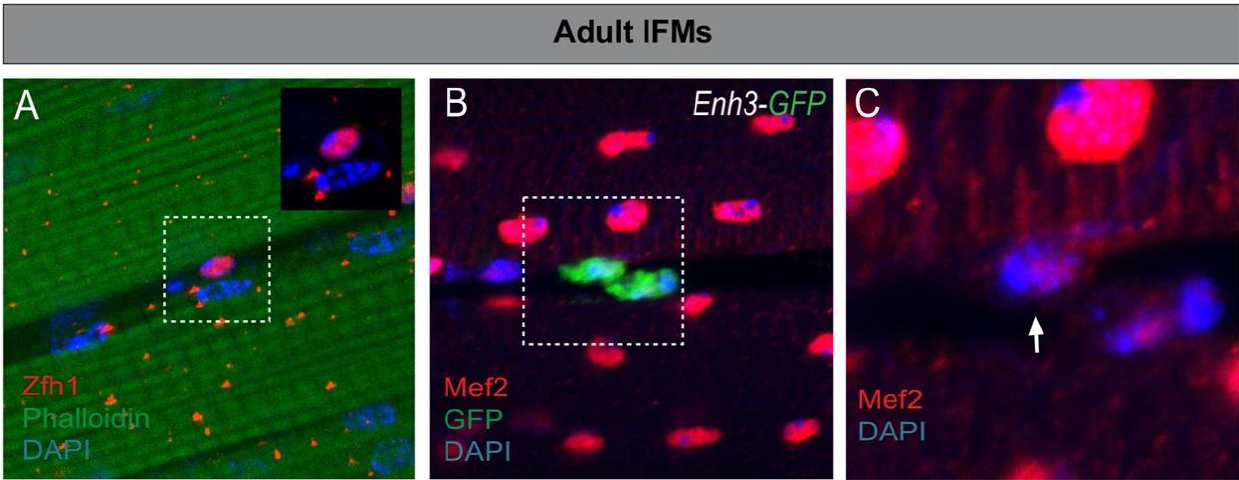
Figure 2. Drosophila adult MuSCs. ( A ) Zfh1 (Red) marks the MuSCs associated with the indirect flight muscles (Phalloidin, green), Nuclei (blue). ( B ) zfh1 enhancer ( Enh3-GFP, [16] ) is activated in the MuSC, characterized by low levels of Mef2 (red, arrow in ( C ) Nuclei (blue).